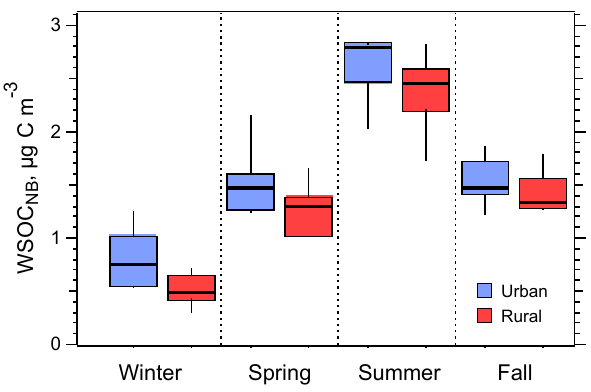
Fig. 7. Box plots of the seasonal mean concentrations of WSOC NB segregated for urban and rural sites. The plot shows median values (thick horizontal bar), 25th and 75th percentiles (lower and upper box bounds, respectively), and 10th and 90th percentiles (lower and upper whiskers, respectively) for each